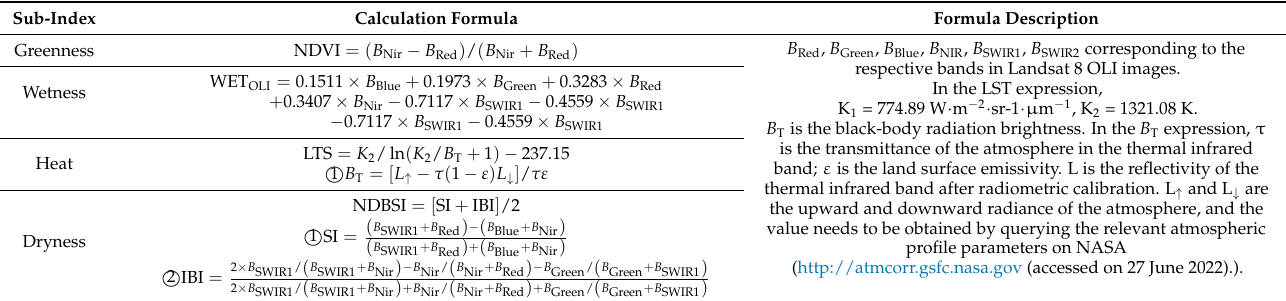
Table 3. Calculation formulas and descriptions of EI